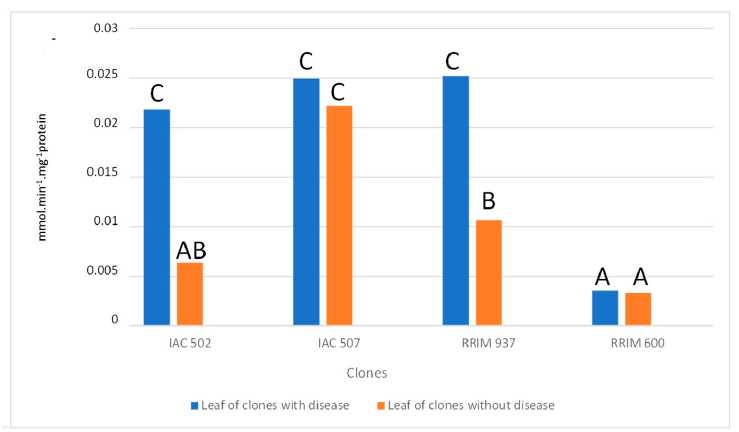
Figure 5. Activity of the enzymes peroxidase in the leaves of rubber trees with and without the presence of anthracnose. Average values followed by the same letter do not differ, according to Tukey’s test, at 5% probability. (Tukey’s test; p < 0.05, Coefficient of variation: 31.57).